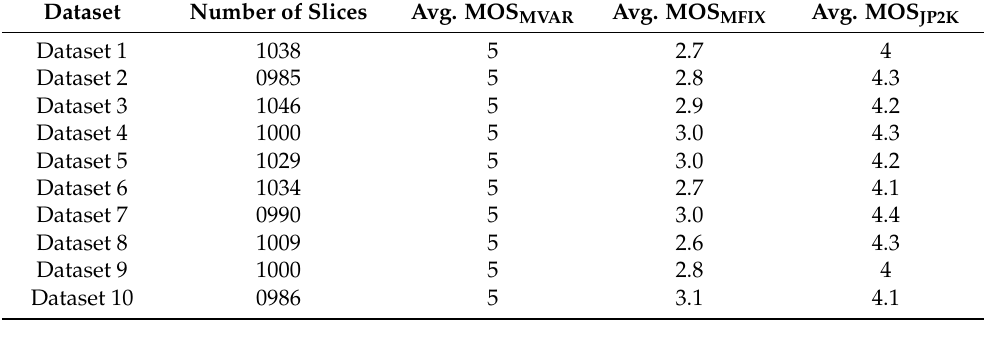
Table 4. Average MOS score for qualitative image quality evaluation for the 10 CTA datasets: (MVAR) proposed method with variable bit rate; (MFIX) proposed method with fixed bit rate; and (JP2K) lossy Jpeg2000 without ROI.